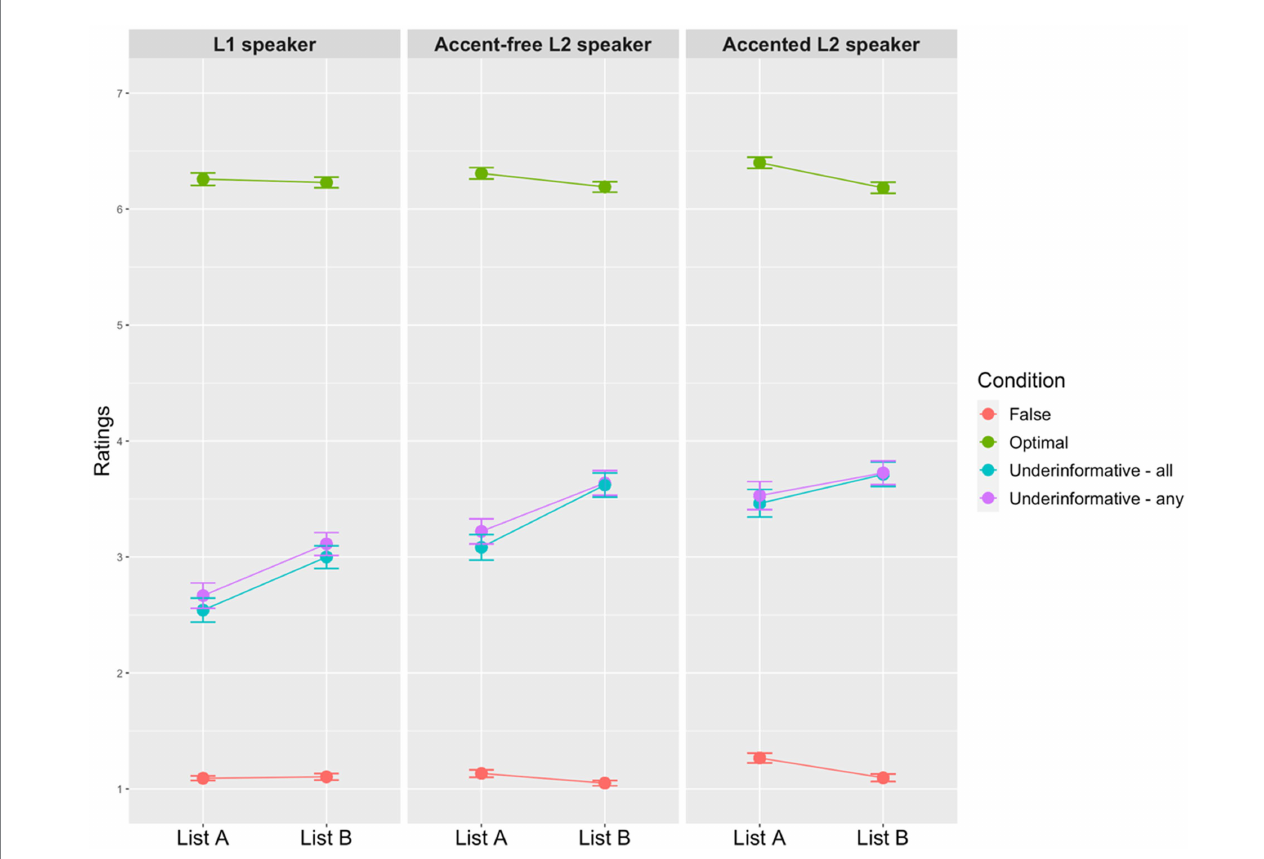
FIGURE 3 Mean ratings of all conditions for scalar implicature with points and standard error bars (the y -axis represents the acceptability of sentences. The higher the ratings are, the more acceptable the sentences